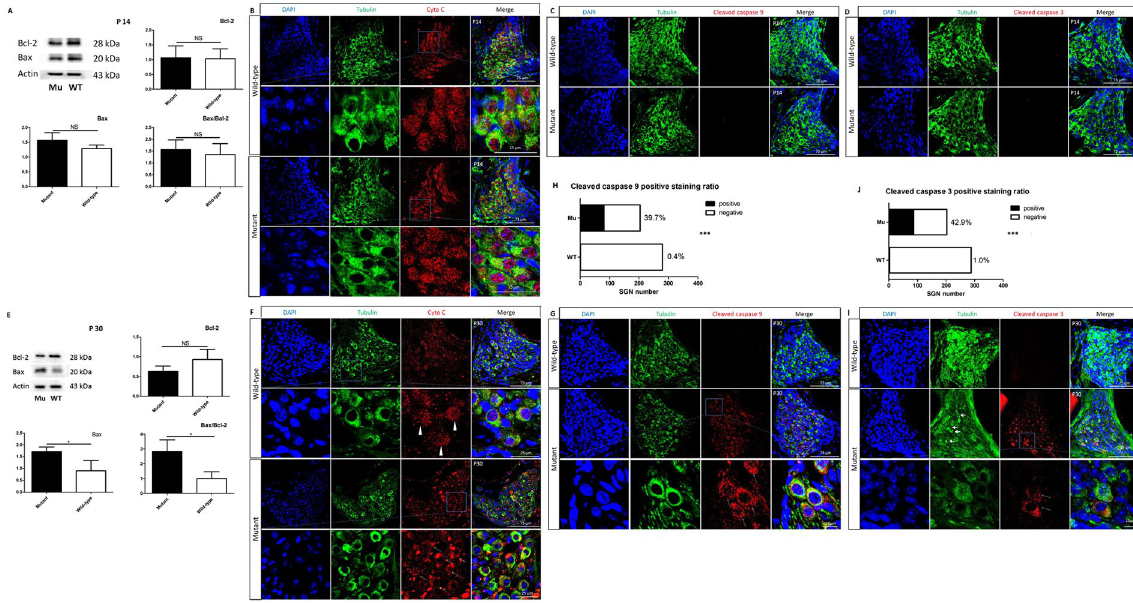
Figure 3. Spag6 mutant SGNs apoptosis in vivo ( A ) Western blotting showed that at P14, there was no statistically significant difference in Bax or Bcl-2 expression, as well as and the ratio of Bax/Bcl-2. ( B ) Both wild-type and mutant mouse SGNs showed normal cytochrome c (red) distribution at P14. ( C ) No positive staining of cleaved caspase 9 could be found in control or mutant SGNs at day P14. ( D ) No positive staining of cleaved caspase 3 could be found in day P14 control or mutant SGNs. ( E ) Western blotting showed that at day P30, expression of Bax (mutant, 1.713 ± 0.1950, N = 3; wild-type, 0.9033 ± 0.4356, N = 3, P < 0.05) and Bax/ Bcl-2 (mutant, 2.833 ± 0.7809, N = 3; wild-type, 0.9937 ± 0.4696, N = 3, P < 0.05) increased significantly in the mutant mice compared to the control group, while there was no significant difference in Bcl-2 expression between the two groups (P > 0.05). “N” indicates the number of mice. ( F ) In P30 wild-type mice SGNs, cytochrome c (red) was distributed uniformly (triangles). However, the distribution of cytochrome c (red) in the mutant SGN on day P30 was not uniform. The staining was assembled into aggregates (arrows). ( G ) The immunofluorescence showed positive staining of cleaved caspase-9 (red) in P30 Spag6 mutant SGN, whereas in littermates few positive staining cells could be seen. ( H ) The positive staining ratio of cleaved caspase-9 in mutant SGNs was significantly increased (muant SGN, n = 204; wild-type SGN, N = 280). ( I ) Positive staining of cleaved caspase-3 (red, arrows) in P30 Spag6 mutant mice was observed, whereas in littermates few positive staining cells were detected. In addition, abnormal SGN could be observed (green, arrows). ( J ) The positive staining ratio of cleaved caspase-3 was significantly higher than that of the control group (mutant SGN, N = 203; wild-type SGN, N = 288). * P < 0.05, ** P < 0.01, *** P < 0.001. Comparisons between two groups in western blotting were tested by Student’s t-test. The rate comparison of cleaved caspase-9 and -3 positive staining between groups was analyzed by the chi-square